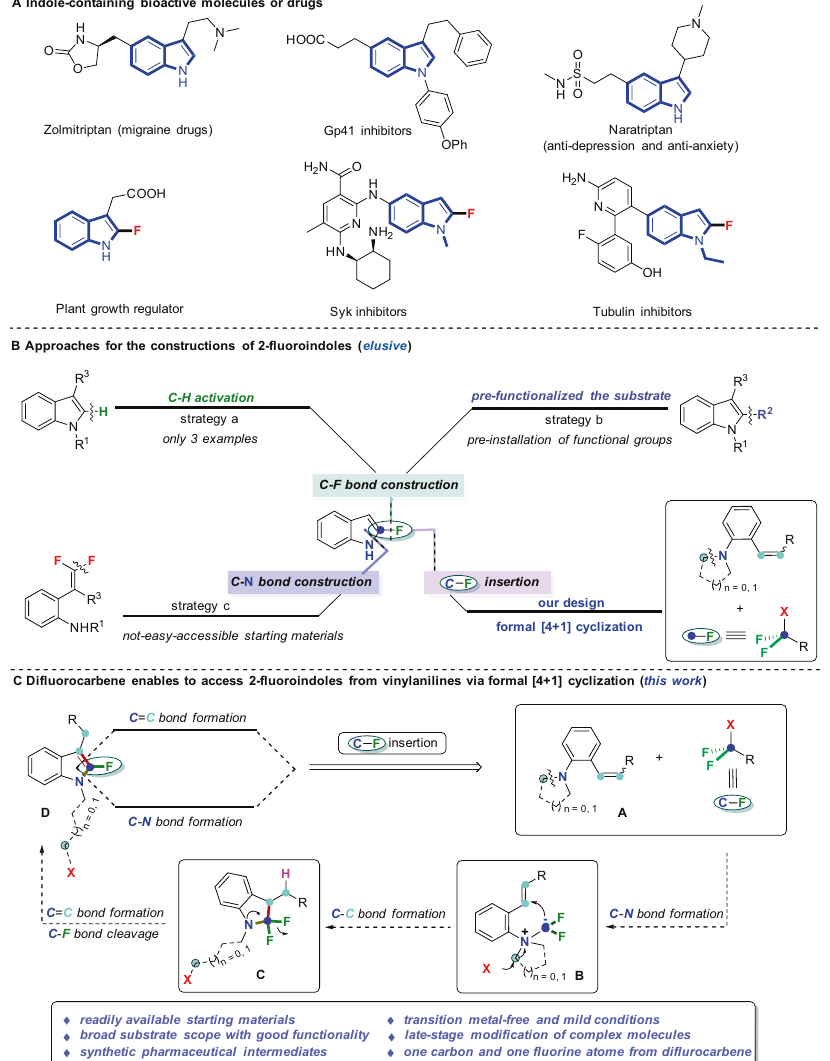
Fig. 1 The importance and synthetic approaches to 2- fl uoroindoles. A Importance of indoles and 2- fl uoroindoles. B Approaches for the construction of 2- fl uoroindoles. C Di fl uorocarbene enables to access 2- fl uoroindoles from vinylanilines ( this work